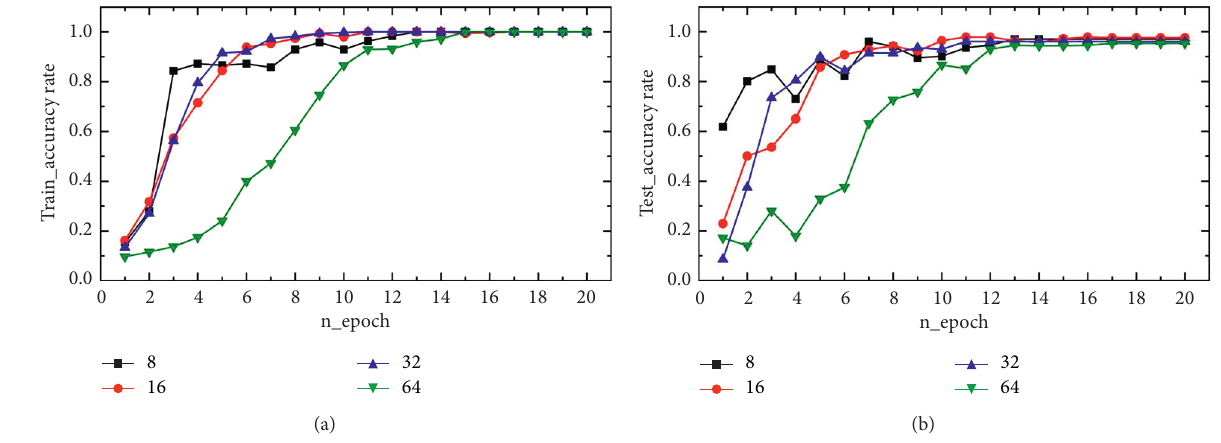
Figure 5: Recognition accuracy curve under different batch_sizes.